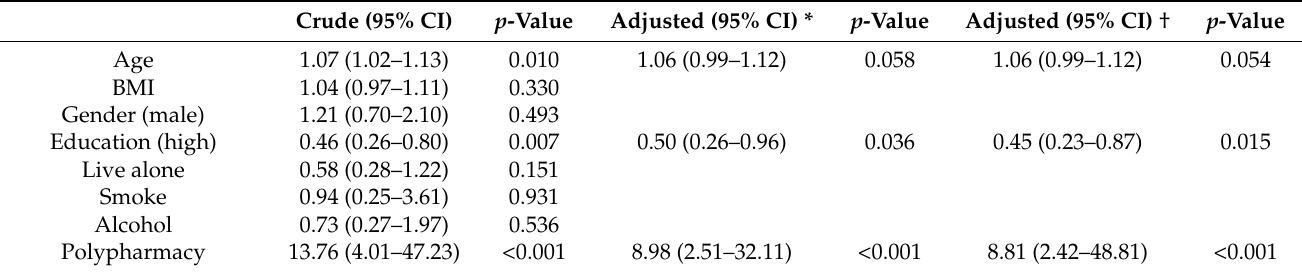
Table 3. Regression model of Cardiovascular Health Phenotypic Classification of Frailty (CHS_PCF)